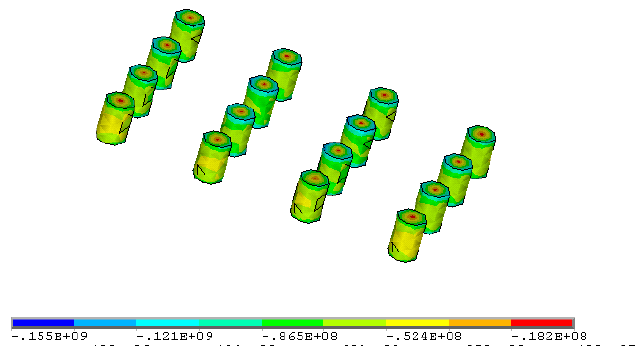
Figure 25. Minimum principal stress distribution of scheme 4 pillars at 1480 mL (parameters of scheme 4: stope height 3.5 m, pillar diameter 2 m, pillar spacing 5 m, pillar row spacing 8 m).